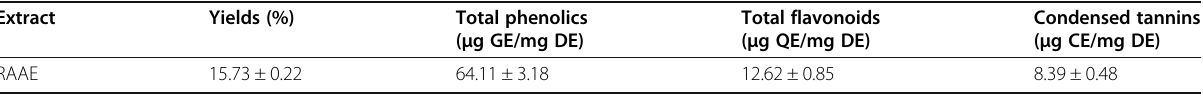
Total flavonoids (µg GE/mg DE) (µg QE/mg DE)